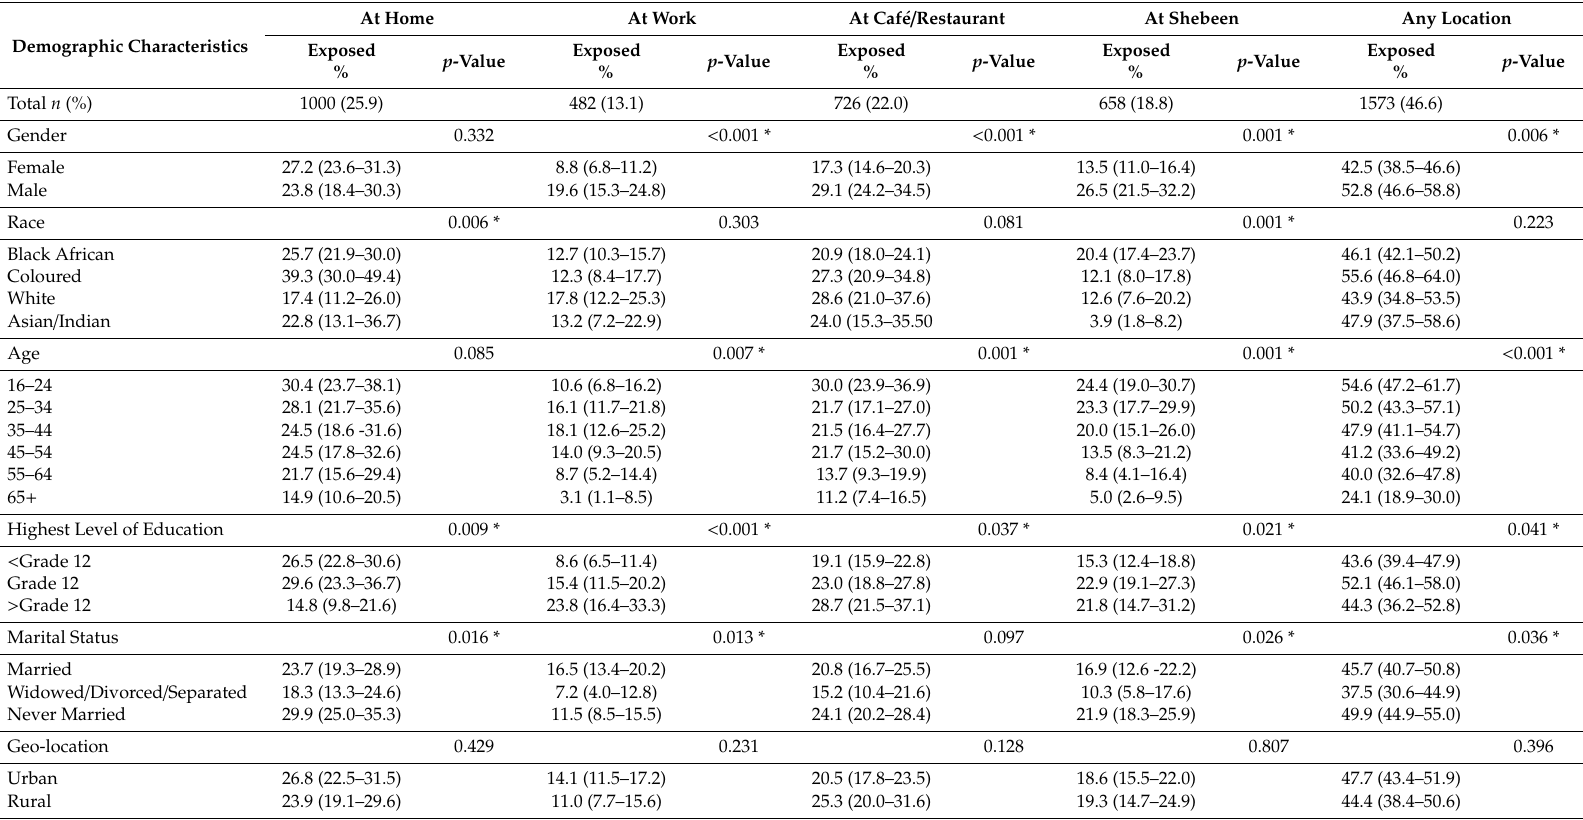
Table 2. Non-smokers’ exposure to second-hand smoke (SHS) at home, work and hospitality